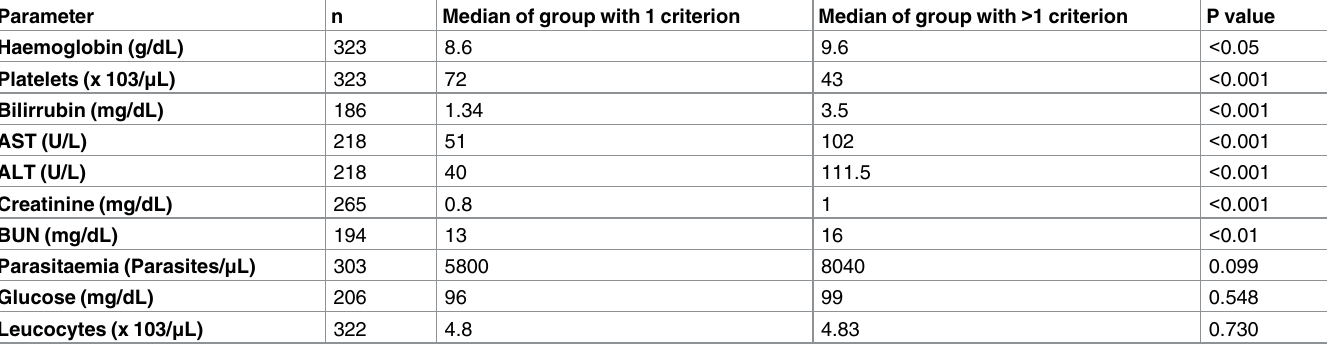
No significant differences on parasite densities were observed between age groups. Although qPCR was retrospectively done for every single patient at enrolment, 213 (42.7%) were nega- tive, presumably due to the treatment initiated upon consultation to the POC, since every referred patient presented a positive TBS. Treatment of these patients consisted of chloroquine (25mg/kg divided in three doses) + primaquine (0.25mg/kg/day for 14 days) for most of P . vivax cases. Artemether + lumefantrine (20mg + 120mg in adults for six doses and according to weight and age in children < 34kg and/or < 14 years of age) for most of P . falciparum cases. Table 3. Laboratory differences in patients with more than one